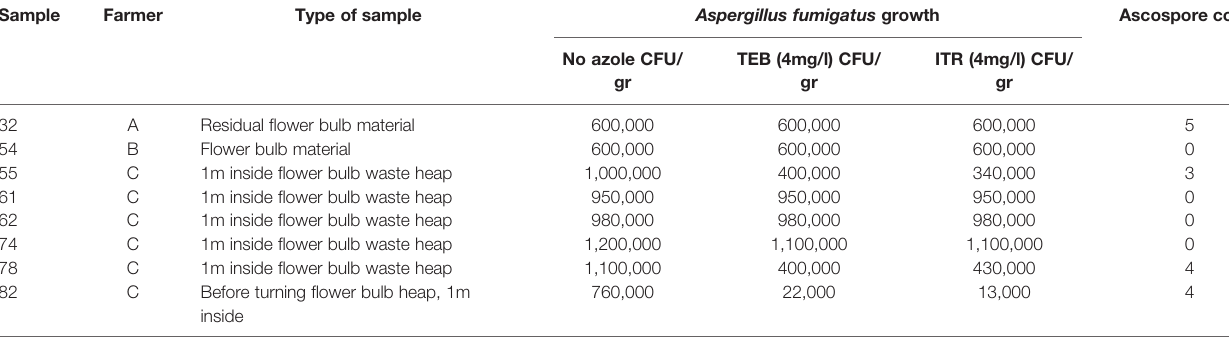
TABLE 2 | Sample characteristics of selected waste material samples with Innosieve grid detection results of ascospore detection.